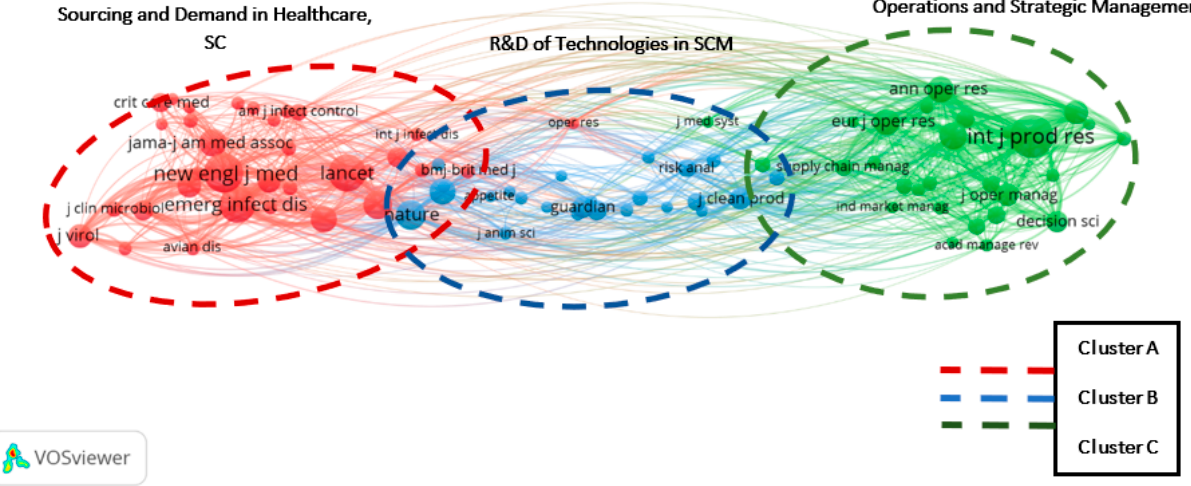
Figure 3. Journal Network Analysis. Statistical Inference through Clustering Analysis (by Journal, Co-Citation and Link Strength).